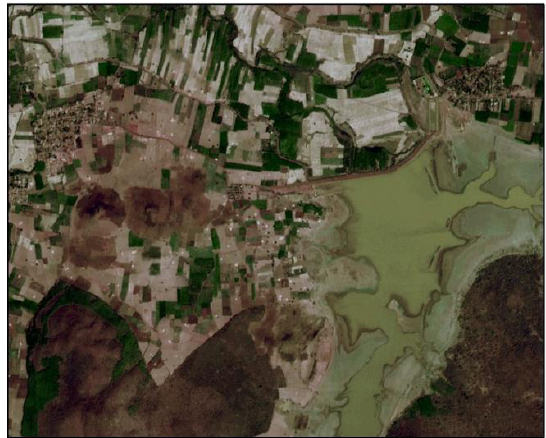
Figure 3a. Visual analysis on quality of spectral transformation could be highly subjective and also LISS-IV does not have blue band to compare the simulated results. simulated blue band with Sentinel blue band which yields a good correlation of 0.90.